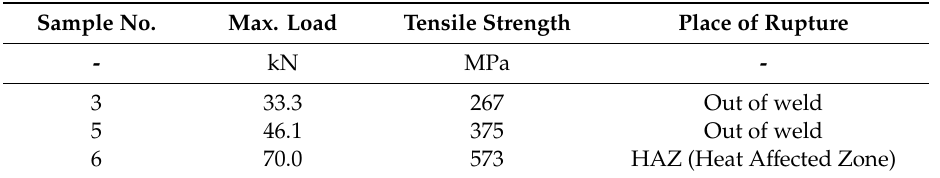
Table 4. Results of tensile test.